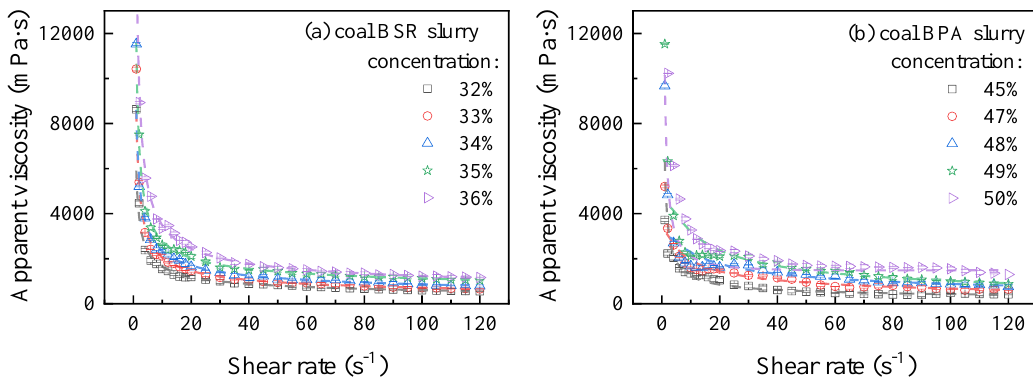
Figure 3. Apparent viscosity of slurry fuels as a function of the shear rate. ( a ) Coal bio-oil derived from straw and husk pyrolysis (BSR) slurries with coal concentrations from 32% to 36%, ( b ) coal bio-oil from pyroligneous acid (BPA) slurries with coal concentrations from 45% to 50%.